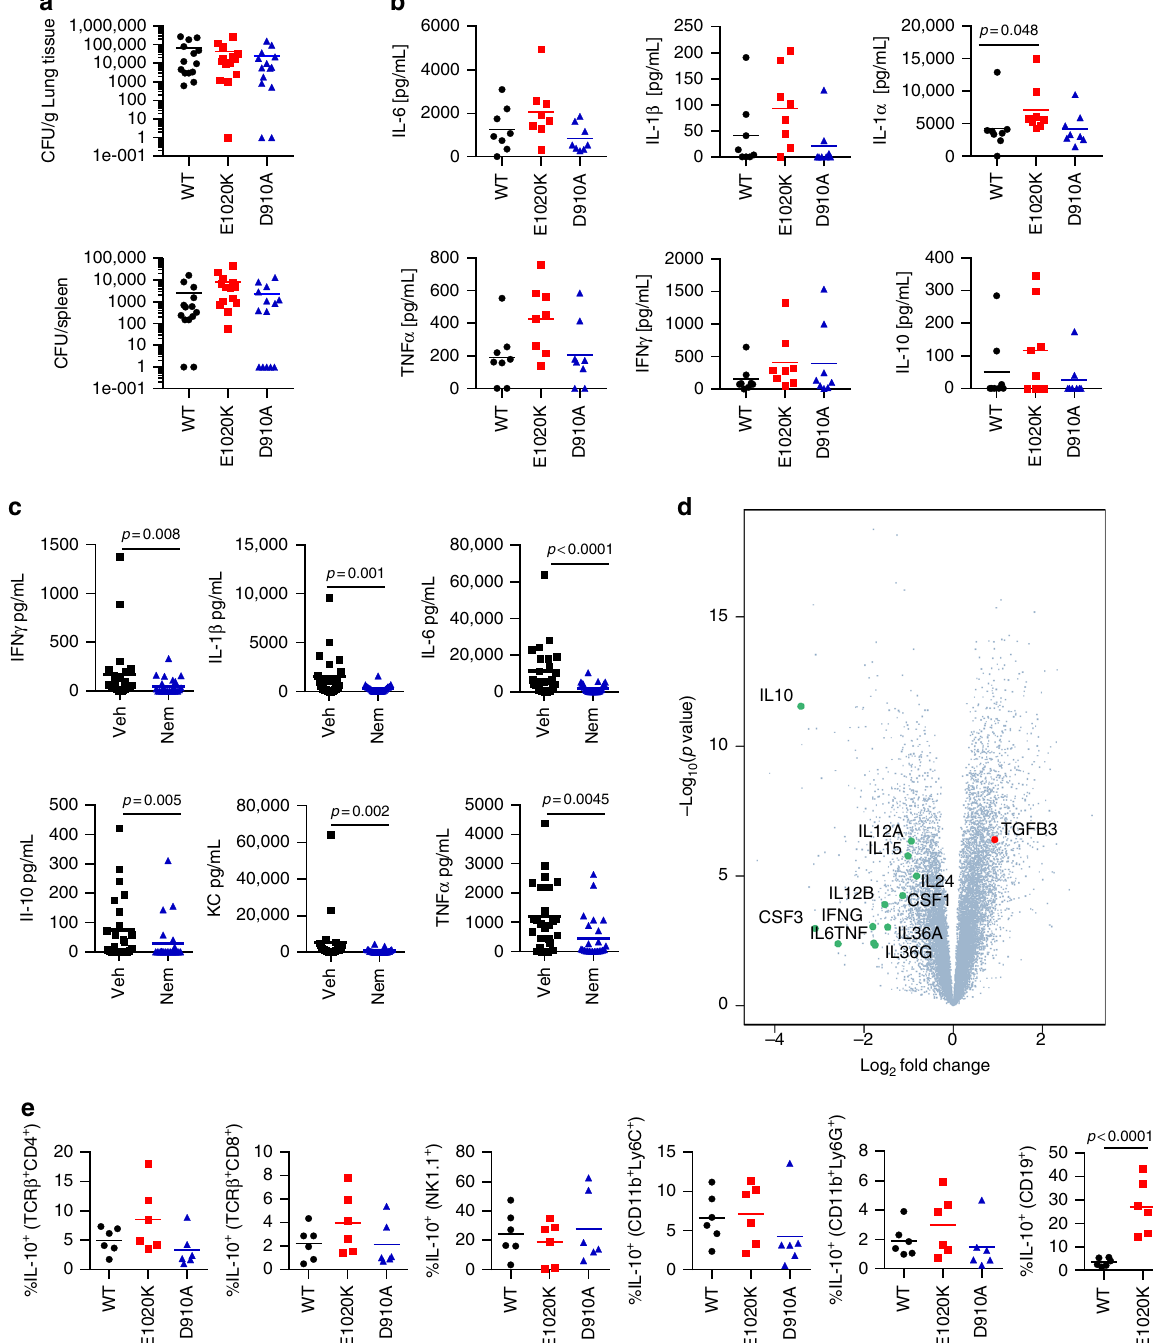
Fig. 7 PI3K δ signaling regulates B cell speci fi c IL-10 production in the lung following S. pneumoniae infection. a 24 h post S. pneumoniae infection, lung and spleen CFU counts were similar in wild-type, p110 δ E1020K-GL and p110 δ D910A mice. b 24 h post-infection, cytokine levels in the lung homogenate showed a trend towards increased TNF α , IL-6, and IL-1 in p110 δ E1020K mice. c 24 h prophylactic treatment with nemiralisib (nem) led to reduced levels of TNF α , IL-6, IL-1 β , IFN γ , and IL-10 in the lungs of wild-type mice compared to vehicle control (veh) treated animals at 24 h post-infection. d Volcano plot (statistical signi fi cance against fold change) of the gene expression changes in response to nemiralisib treatment showed reduced levels of pro-in fl ammatory cytokines as well as IL-10 at 24 h post infection compared to vehicle control treatment. All genes analyzed are shown (gray dots) with the cytokines of interest labeled and colored; green for those with a negative fold change, red for positive fold change. e Analysis of immune cell subsets in Il10 ITIB reporter mice at 24 h post-infection showed that the proportion of IL-10 producing B cells is signi fi cantly increased in p110 δ E1020K-GL mice and reduced in p110 δ D190A mice compared to wild-type mice, with similar trends in T cells and myeloid cells not reaching signi fi cance. (Mean values shown; data-points represent individual animals. a Results from two independent studies combined, n = 14; b representative data from three independent studies n = 8; c Combined data from four independent experiments n = 25; d data from 1 study, n = 6; e representative data from two independent studies n =